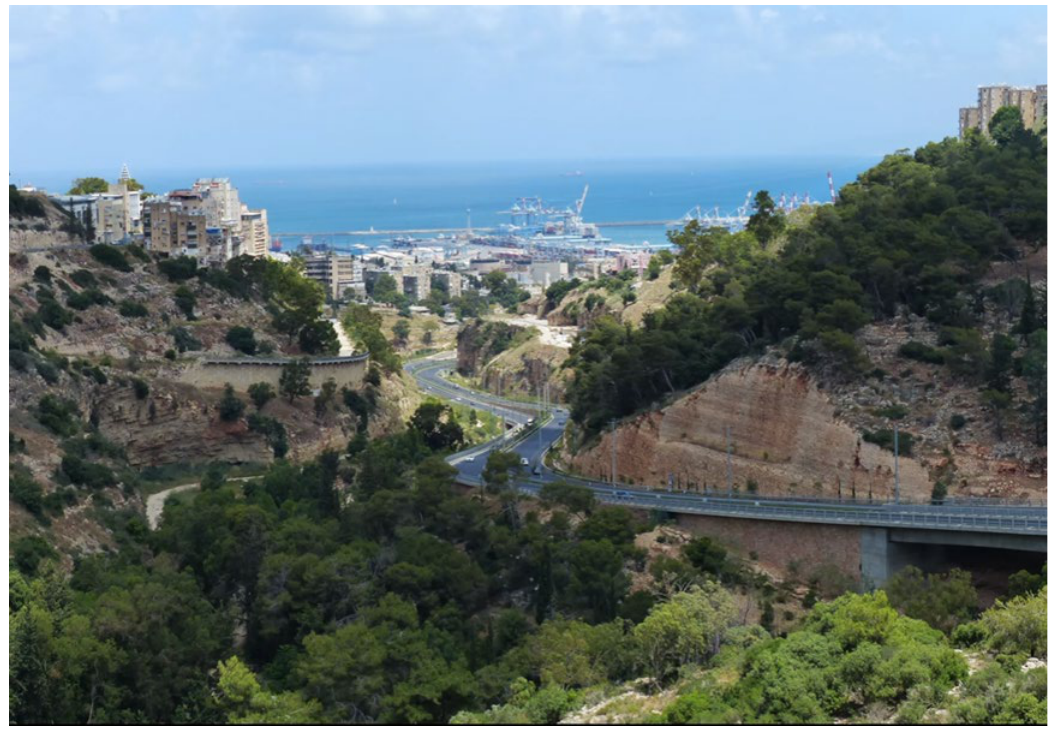
Figure 1 Wadi Rushmia, photograph by the author,